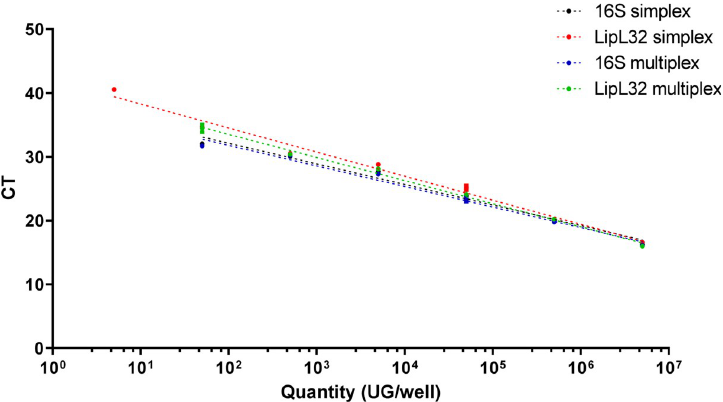
Fig 2. Comparison between simplex and multiplex qPCR for the two targets: 16S gene and LipL32 gene; using range of plasmids.